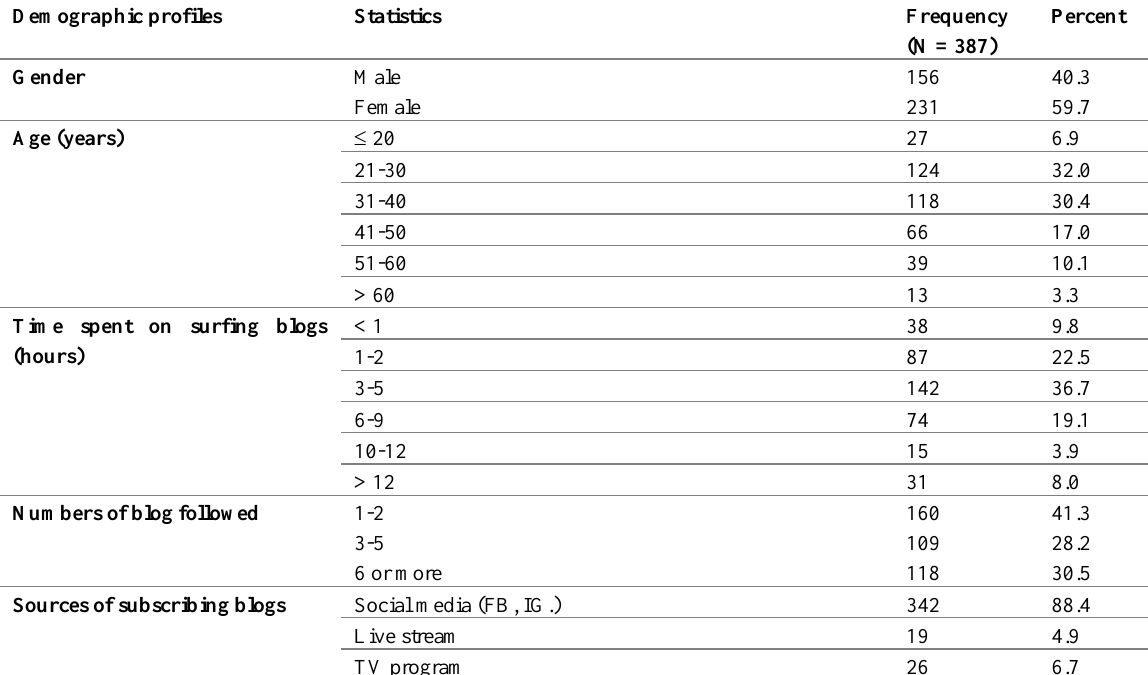
Table 1: Respondents’ Demographic